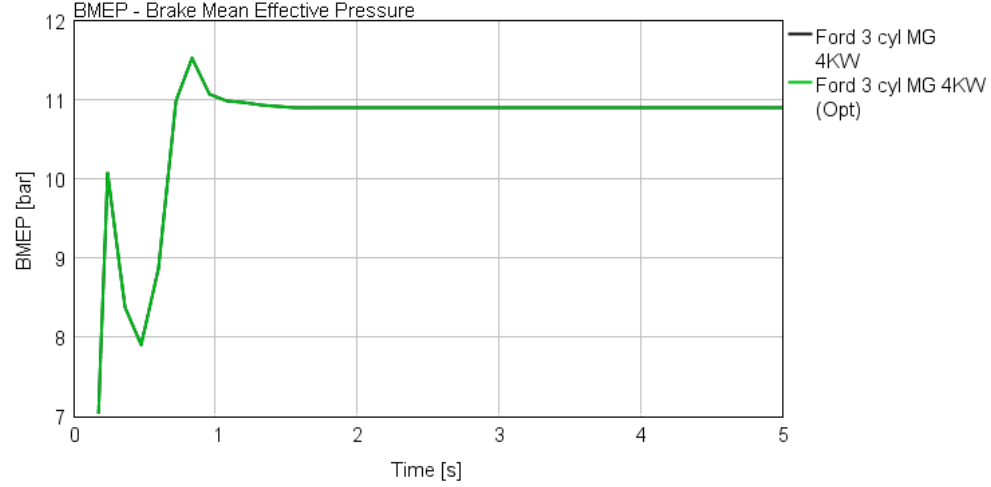
Figure 26. Brake mean effective pump (BMEP) graphs of the EAT 3 kW model for the initial and optimized compressor.